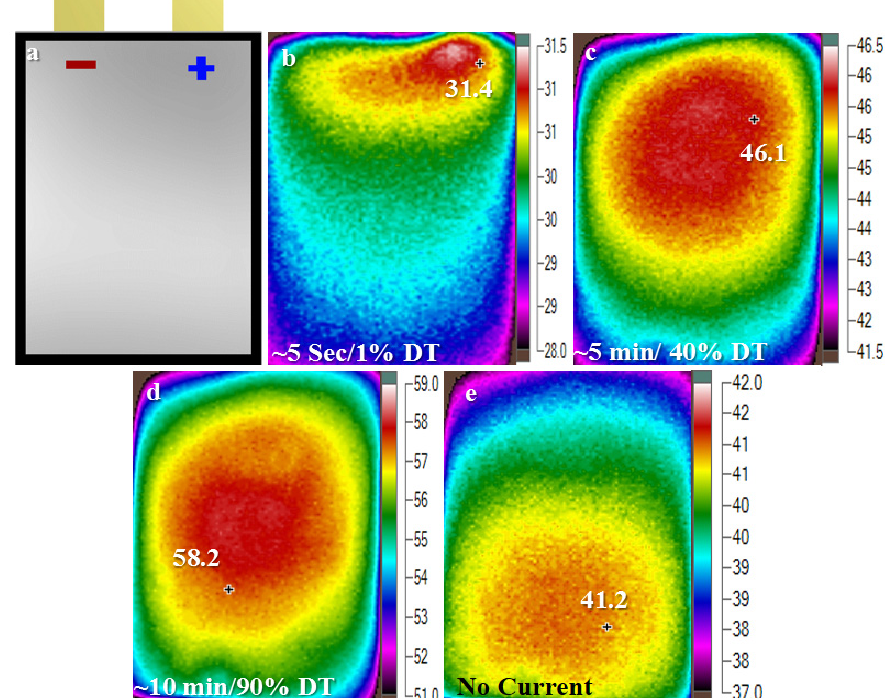
Figure 4. ( a ) Schematic of the NMC 20 Ah cell. IR images during discharge at 100 A along with the location of respective maximum temperature; ( b ) after ~5 s of discharge or ~1% of total discharge time (DT); ( c ) after 5 min or ~40% DT; ( d ) after 10 min or ~90% DT; ( e ) during rest (zero current). Different temperature scales were used here to show distinguishable non-uniformity of surface temperature distribution.